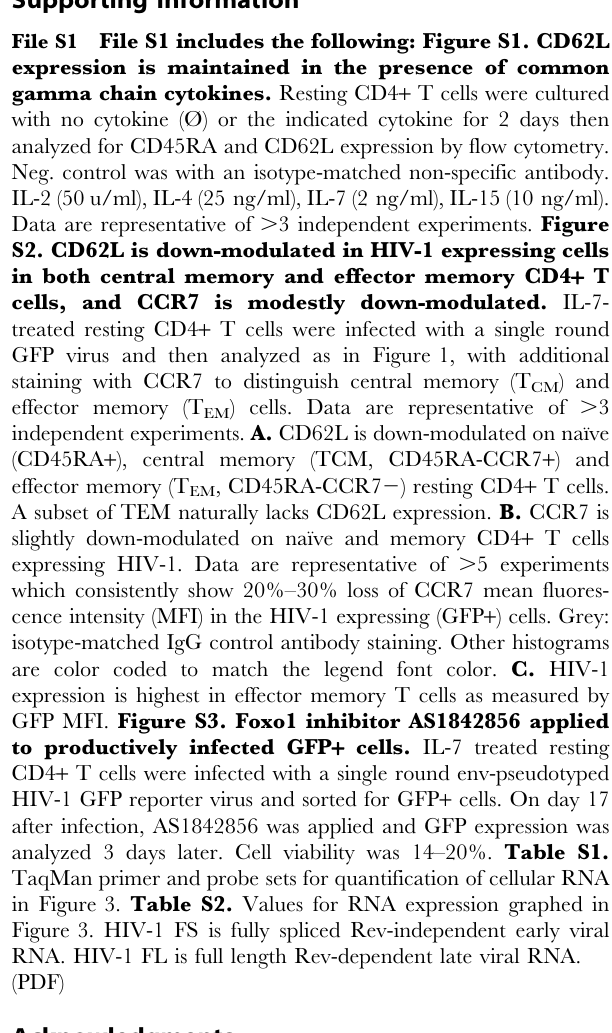
Figure 3. HIV-1 FS is fully spliced Rev-independent early viral RNA. HIV-1 FL is full length Rev-dependent late viral